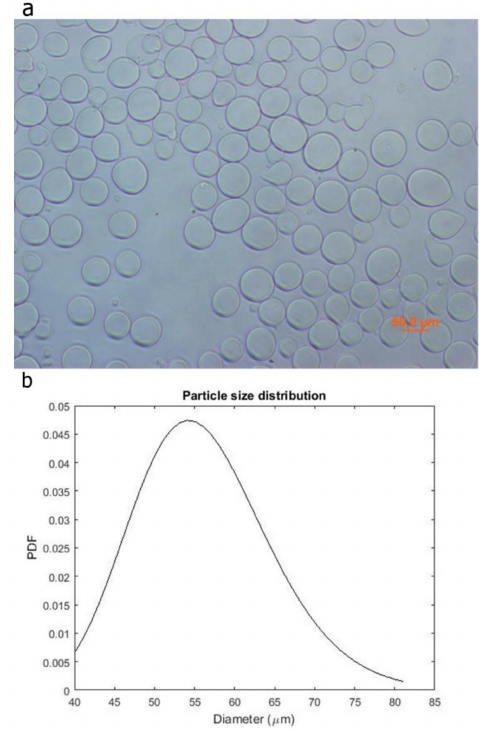
Figure 1. Optical image of the alginate microspheres ( a ) and the Probability Density Function of their diameter distribution ( b